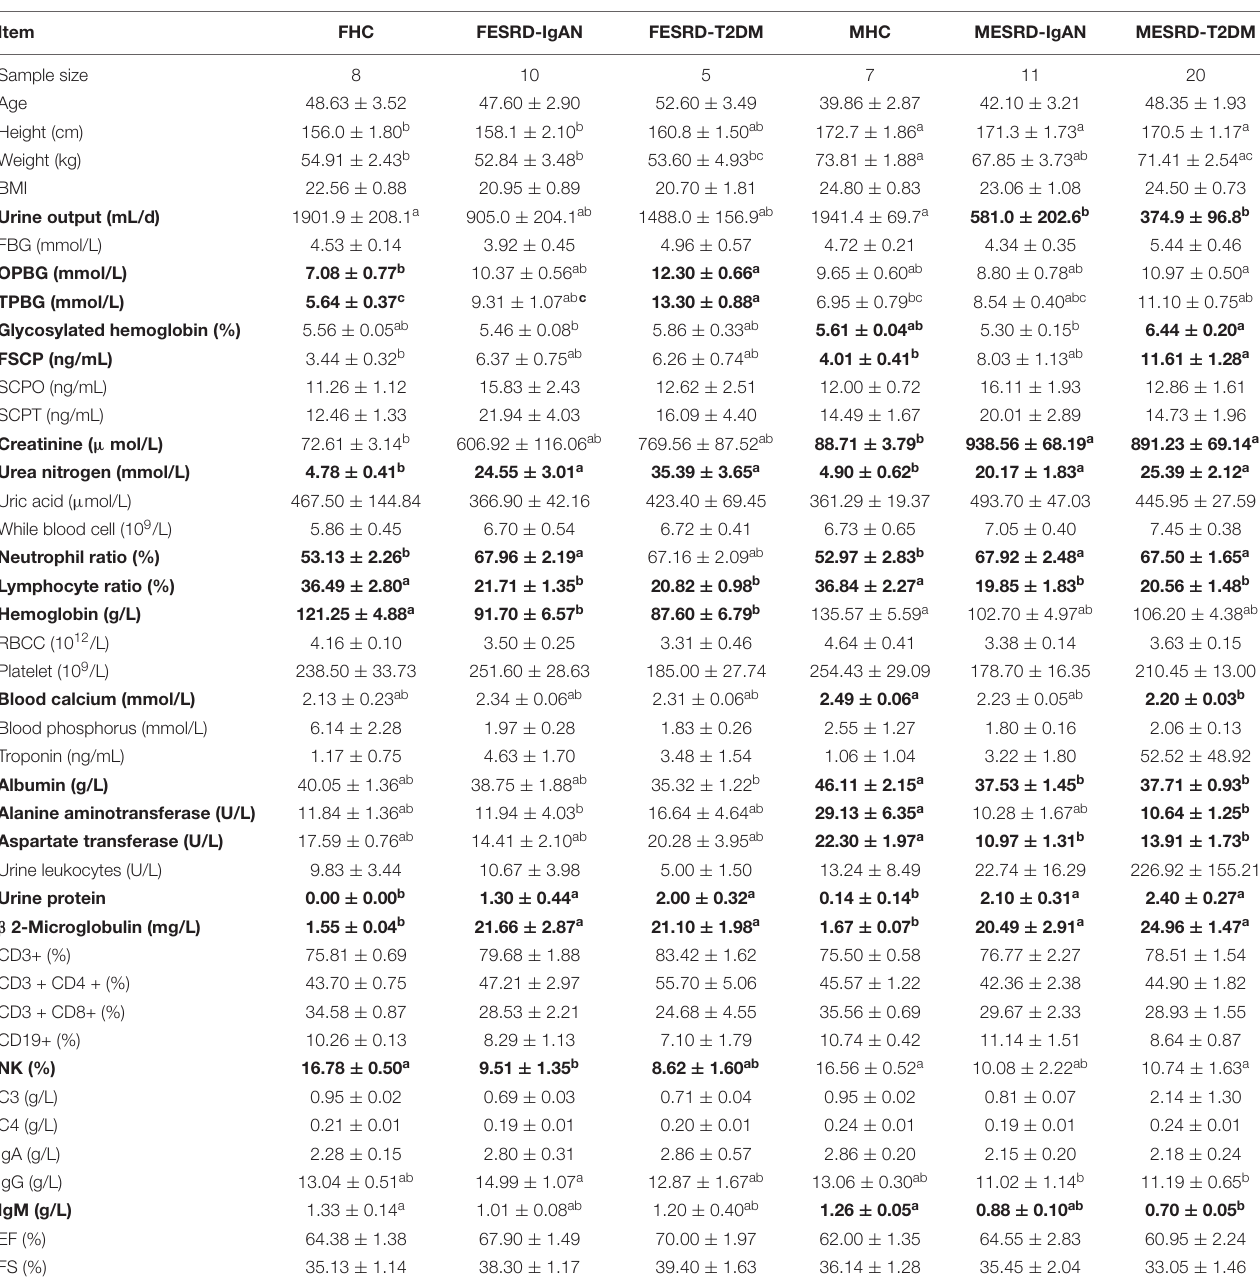
TABLE 1 | General characteristics, and physiological and biochemical indices of blood and urine of